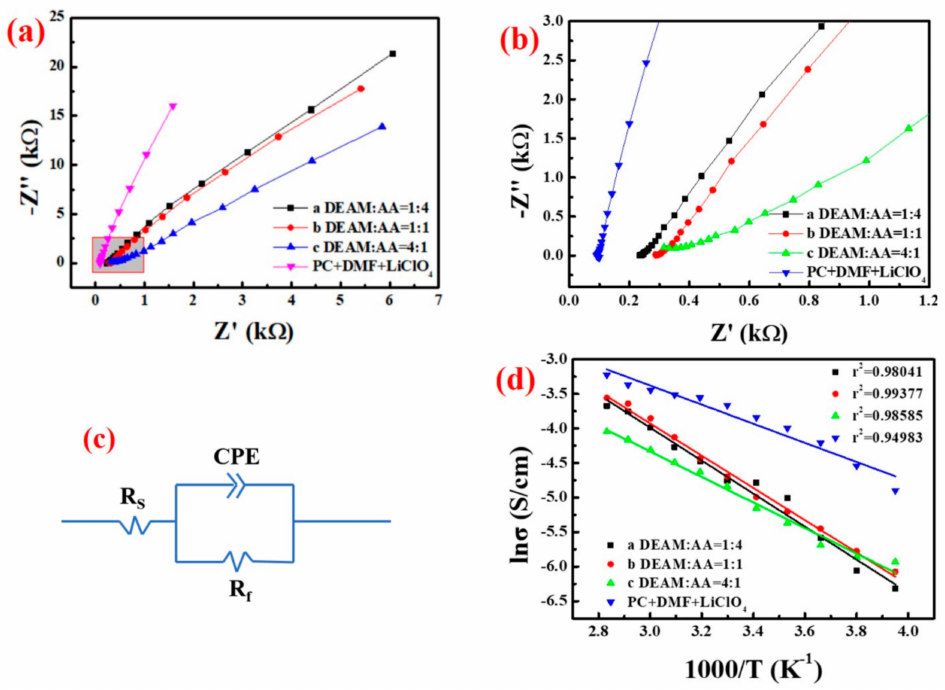
Figure 4. ( a ) AC impedance of PADA gel electrolytes with different volume ratios of DEAM and AA at 20 ◦ C Spectrogram; ( b ) Enlarged view of the rectangular area in ( a ); ( c ) Equivalent circuit diagram of electrolyte fitted by Zview software; ( d ) The ionic conductivity of PADA gel electrolyte with different volume ratios of DEAM and AA changes with